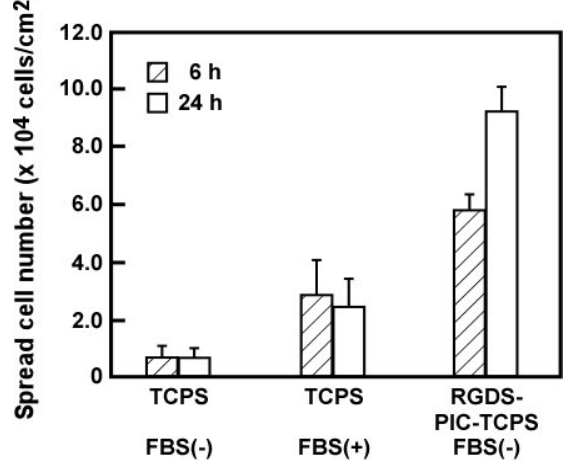
Figure 10. Comparisons of human umbilical vein endothelial cells (HUVECs) spreading on tissue culture polystyrene surface (TCPS) and Arg-Gly-Asp-Ser peptides (RGDS) modified poly( N -isopropylacrylamide- co -2-carboxyisopropylacrylamide) grafted TCPS (RGDS-PIC-TCPS) after 6 and 24 h cultures with or without fetal bovine serum (FBS) at 37